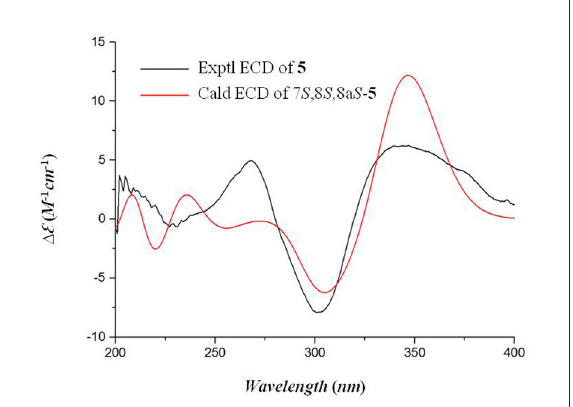
FIGURE4 The experimental and calculated ECD spectra of compound 5 .